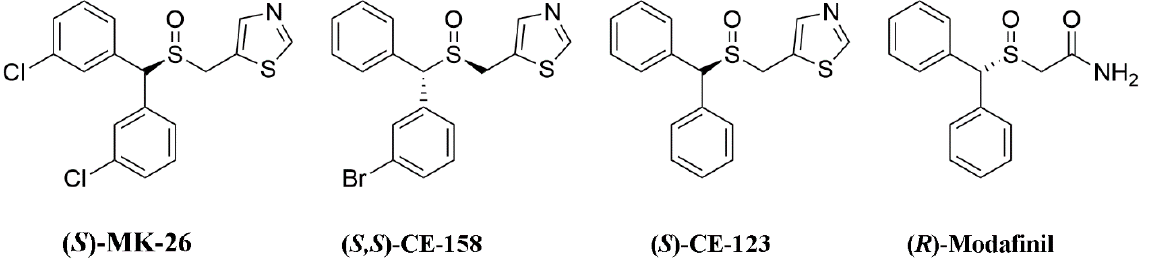
Figure 1. Structures of ( S )-MK-26; ( S , S )-CE-158; ( S )-CE-123; and ( R )-Modafinil. The ( S )-MK-26 molecule has only one chiral center (having thus only two optical enantiomeric, “R” and “S” stereoiso- mers). ( S )-MK-26 was initially generated as a racemic (an equal mixture of enantiomers) compound and afterwards separated by means of chiral-phase discrimination using HPLC chromatography. This physical separation method first yielded a less retained enantiomer (( S )-MK-26), and a second, stronger retained enantiomer (( R )-MK-26; “9” in Scheme 1).